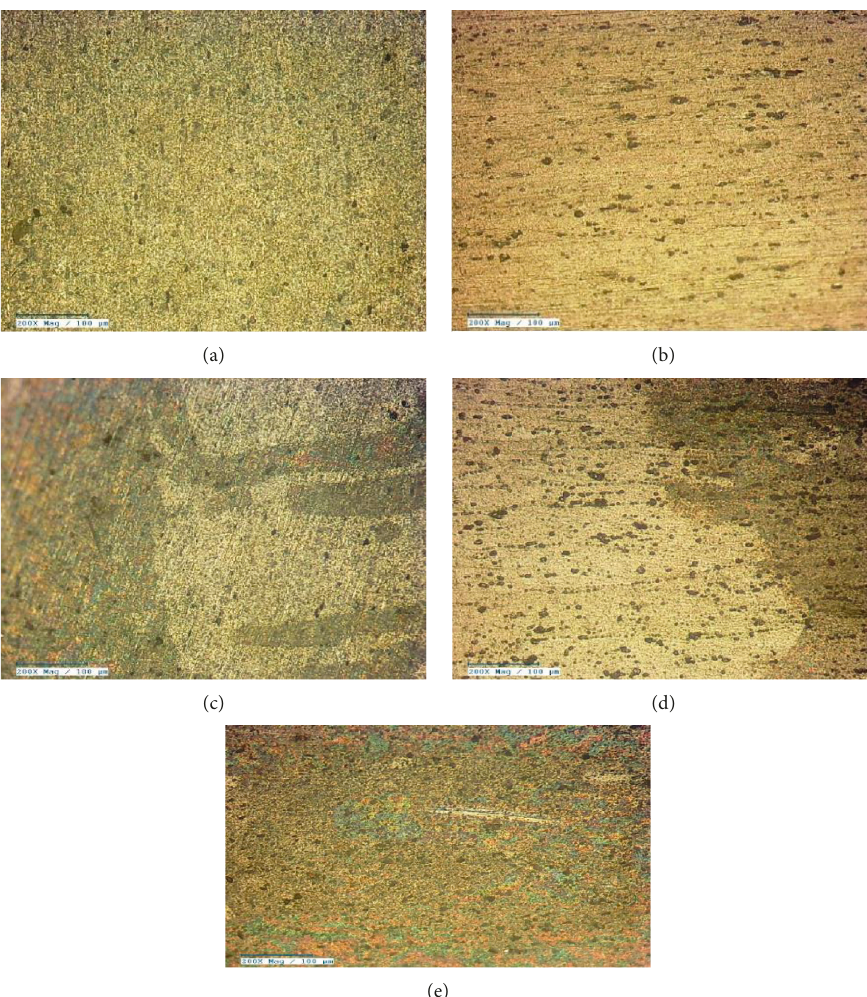
Figure 9: Optical microstructure image. (a) Al5456 base metal, (b) Al6262 base metal, (c) HAZ in Al5456, (d) HAZ in Al6262, and (e) weld